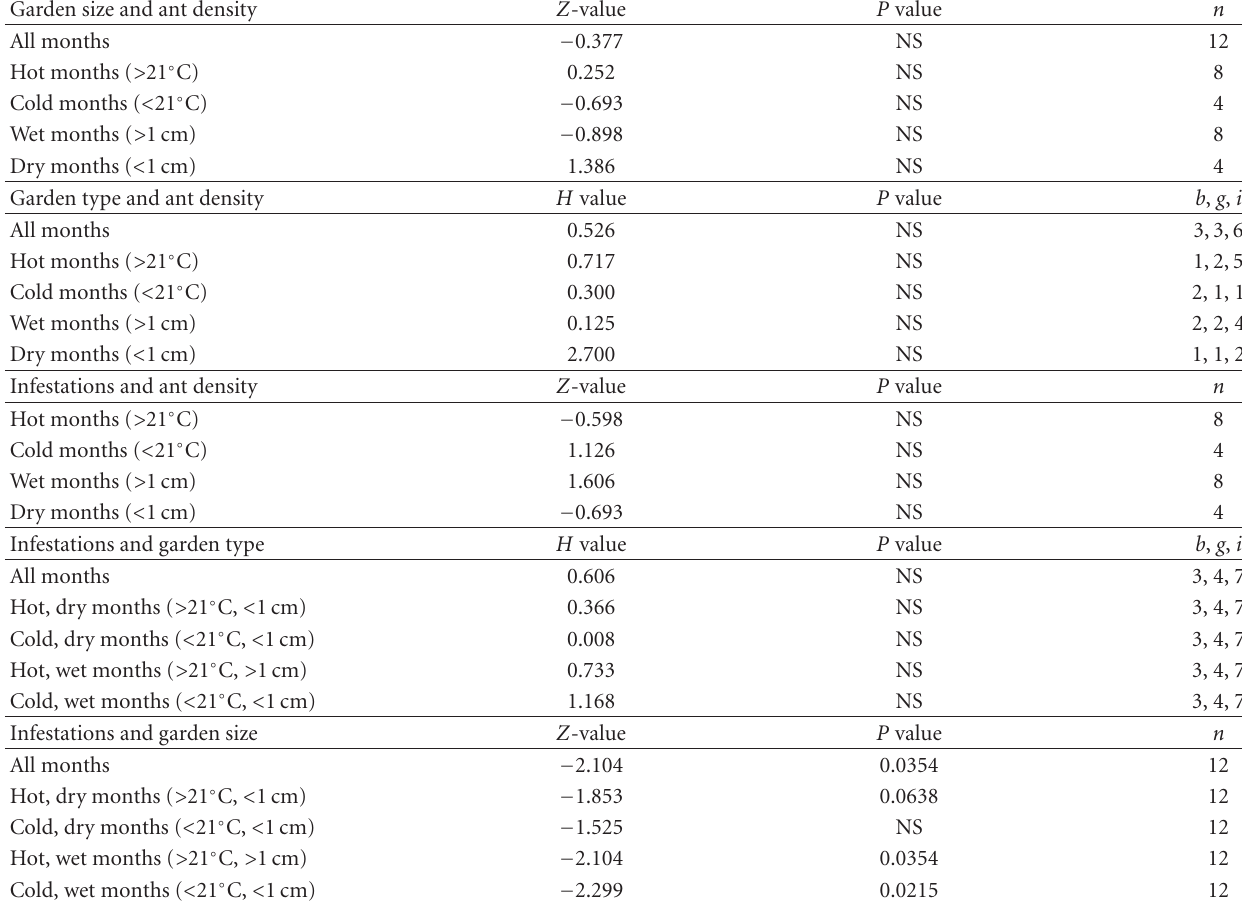
Table 1: Summary statistics using Spearman rank correlations ( Z -values) and Kruskal-Wallis tests ( H values). For the Kruskal-Wallis tests b , g , and i refer to number of gardens with predominant groundcover of bushes, grass or ivy,